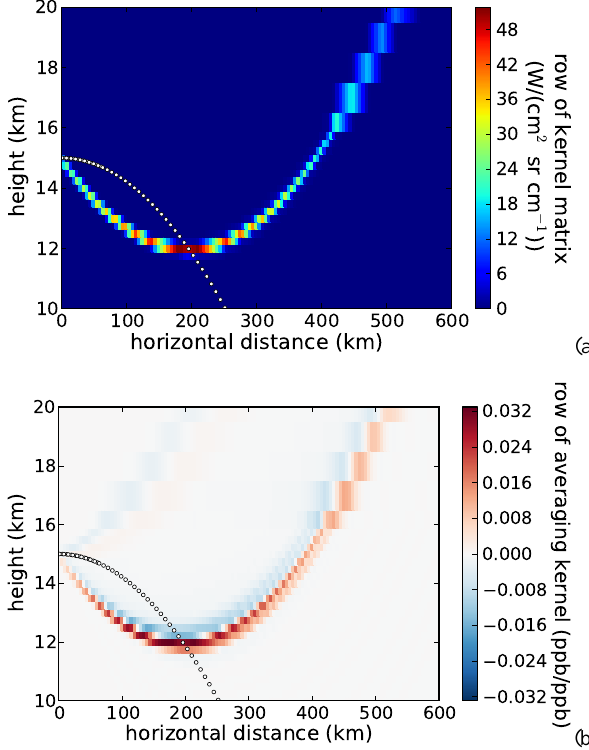
Fig. 16. This figure examines the effect of the assumption of horizontal homogeneity on a single 1-D retrieval more closely. (a) Shows exemplarily the weighting function with tangent height closest to 12km. The 1-D weighting function corresponds to the horizontal sum of this matrix. (b) Depicts the row associated with 12km retrieval height of the full 2-D averaging kernel matrix that shows the contributions of higher layers to the retrieval